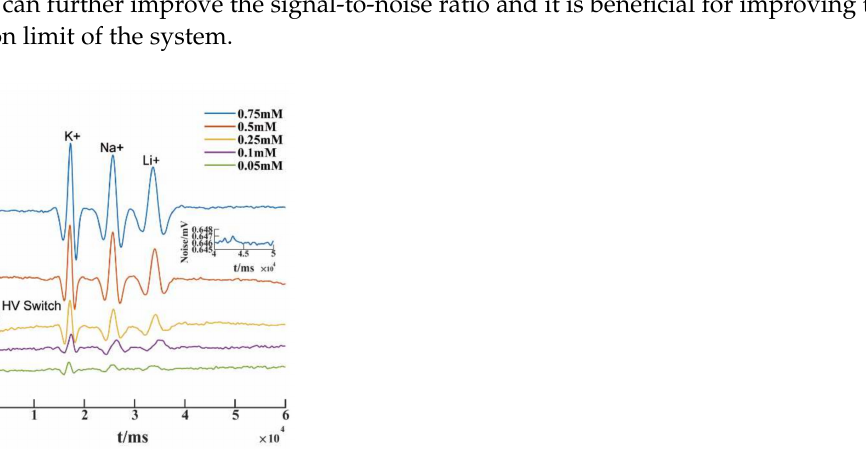
Figure A2. Signals filtered by Butterworth (cutoff frequency = 5 Hz), the inset diagram is the baseline noise fluctuation.